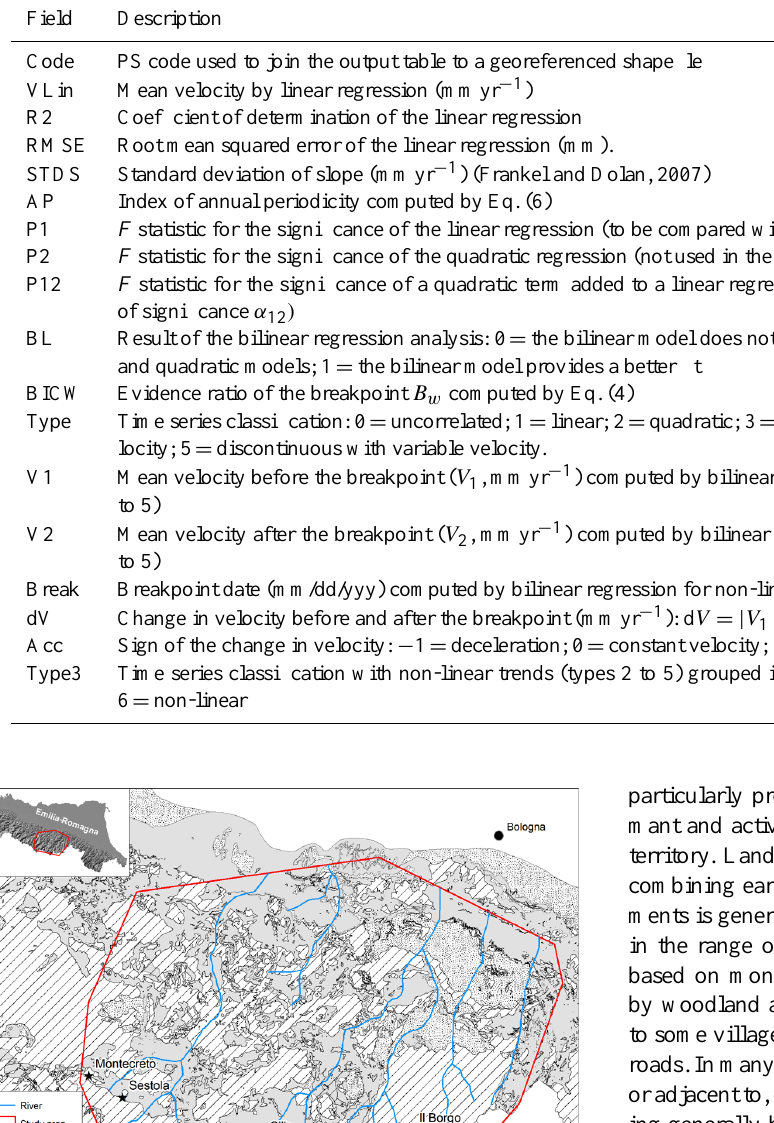
(Fig. 6). In the area, elevation ranges from 150 m at the Apen- nines foothills to the north, to about 1700 m to the